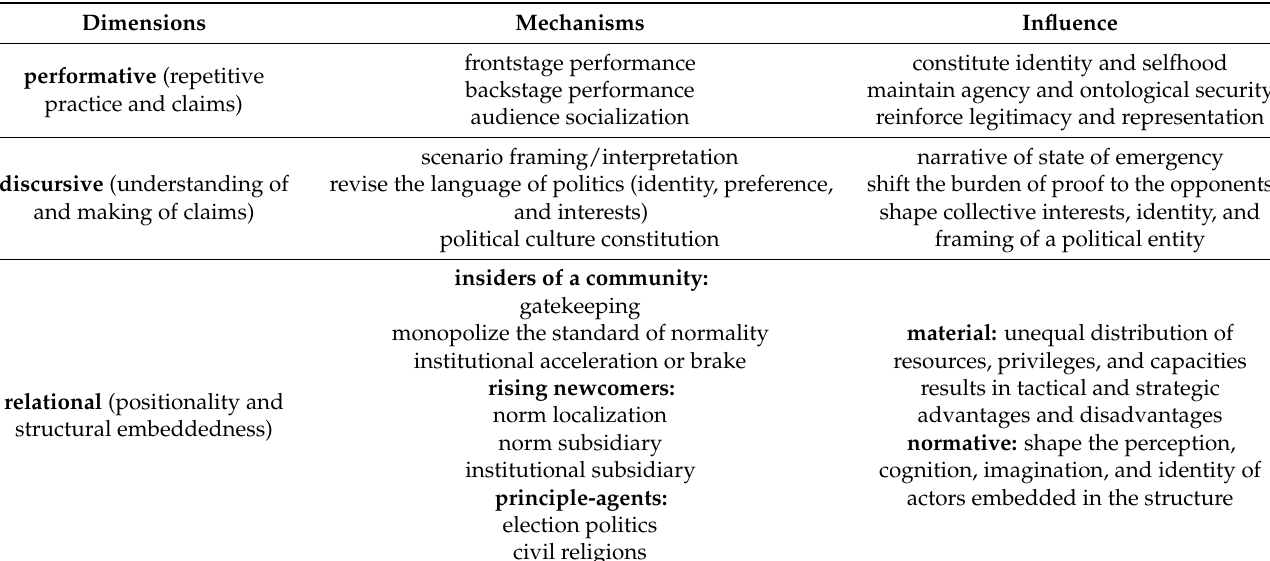
Table 1. Three-dimensional religious soft